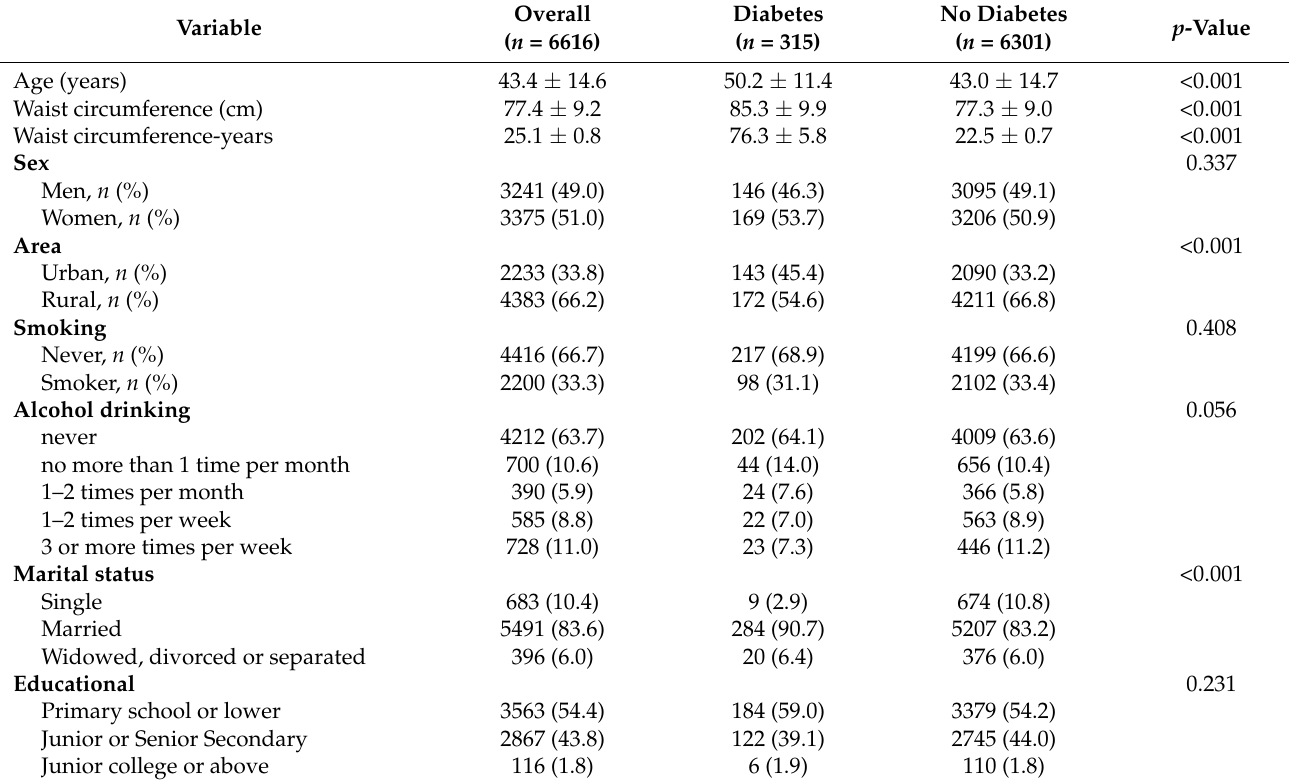
Table 1. Participant characteristics of the diabetic and non-diabetic study populations a